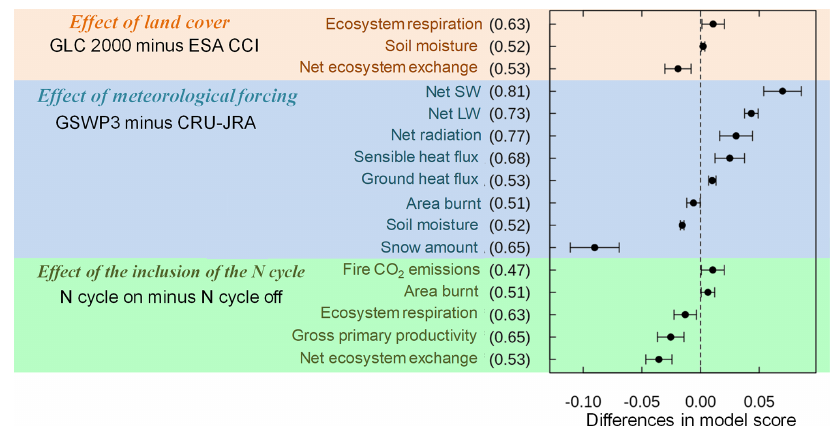
Figure 12. Summary of differences in overall scores for model-simulated quantities and combinations for which the differences are statis- tically significant. The scores in parentheses for each quantity are the average scores across the eight simulations and provide context. The error bars denote the 95% confidence interval, as explained in the